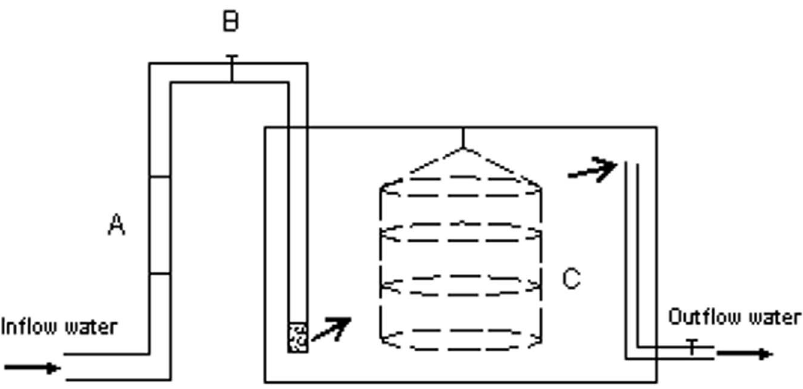
Figure 1. Schematic diagram of individual experimental biotanks. Each biotank measured 75 6 50 6 50 cm in size. A, Flowmeter; B, Control valve; C, Lantern net deployed in a biotank for bivalve culture.